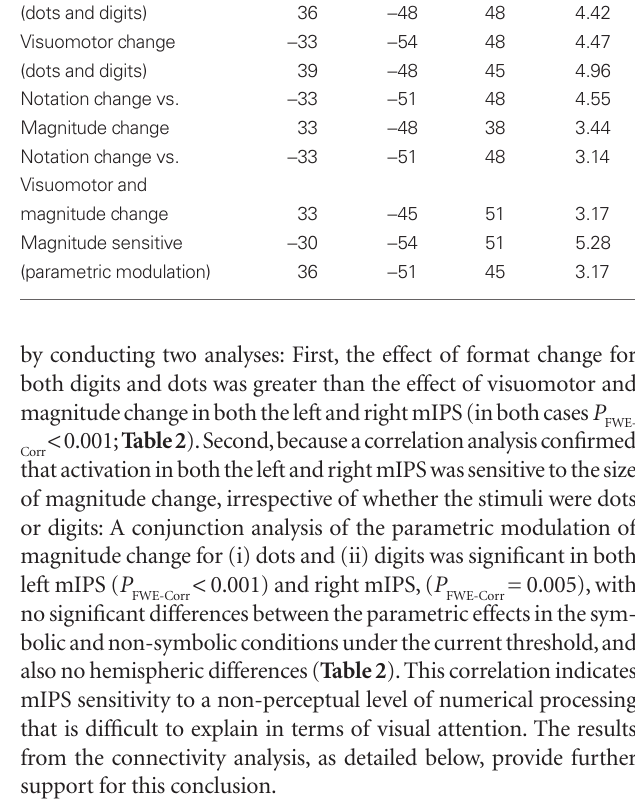
Figure 4 | Conjunction analysis of magnitude change, format change, and visuomotor change. The only significant activation was found in the bilateral middle IPS ( p < 0.001, uncorrected, the peak was significant at p < 0.05 corrected). This activation falls within the coordinates of a recent